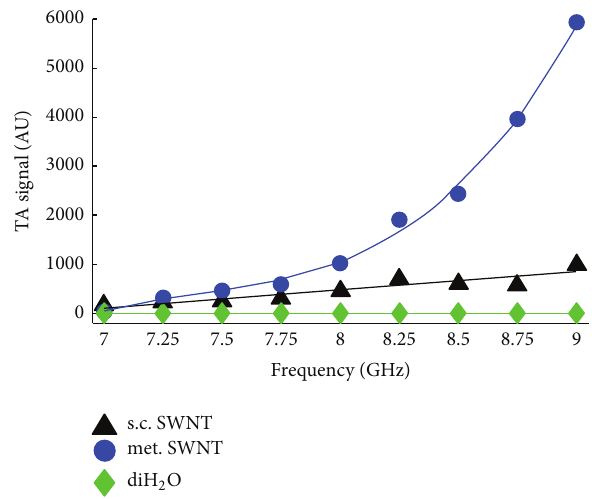
Figure 5: Expected TA spectra of SWNTs calculated by compen- sating for contributions from the background water in each SWNT solution. The water and semiconducting SWNTs have a linear = 0.145 AU/GHz, 𝑅 2 = 0.91 ) and ( 𝑚 spectra ( 𝑚 water 366 AU/GHz, 𝑅 2 = 0.84 ), respectively. The frequency-dependent signal from metallic SWNTs followed an exponential function (half- = 0.84 life = 0.49 GHz, 𝑅 2 adj